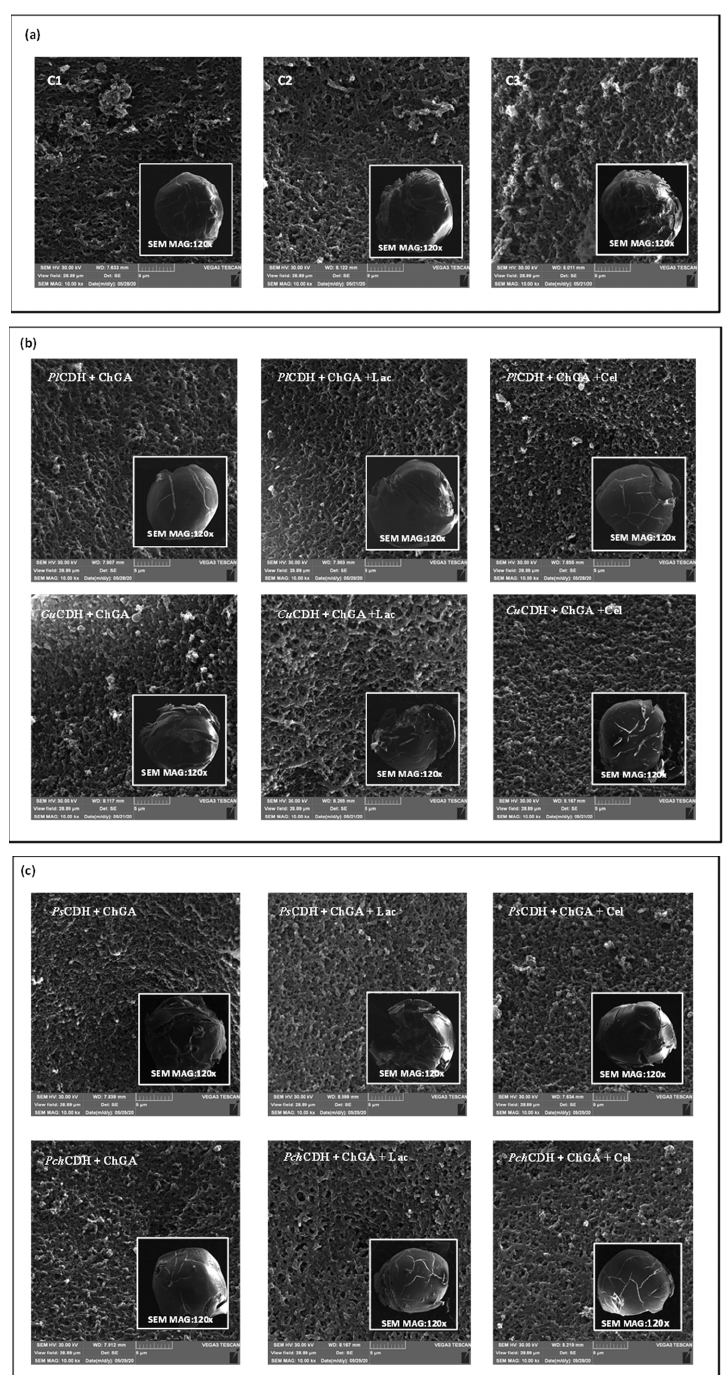
Figure 3. ( a ) SEM micrographs of the surface of chitosan with glutaraldehyde (ChGA) (C1-control), ChGA + Lac (C2-control), ChGA + Cel, (C3-control); ( b ) SEM micrographs of the surface of